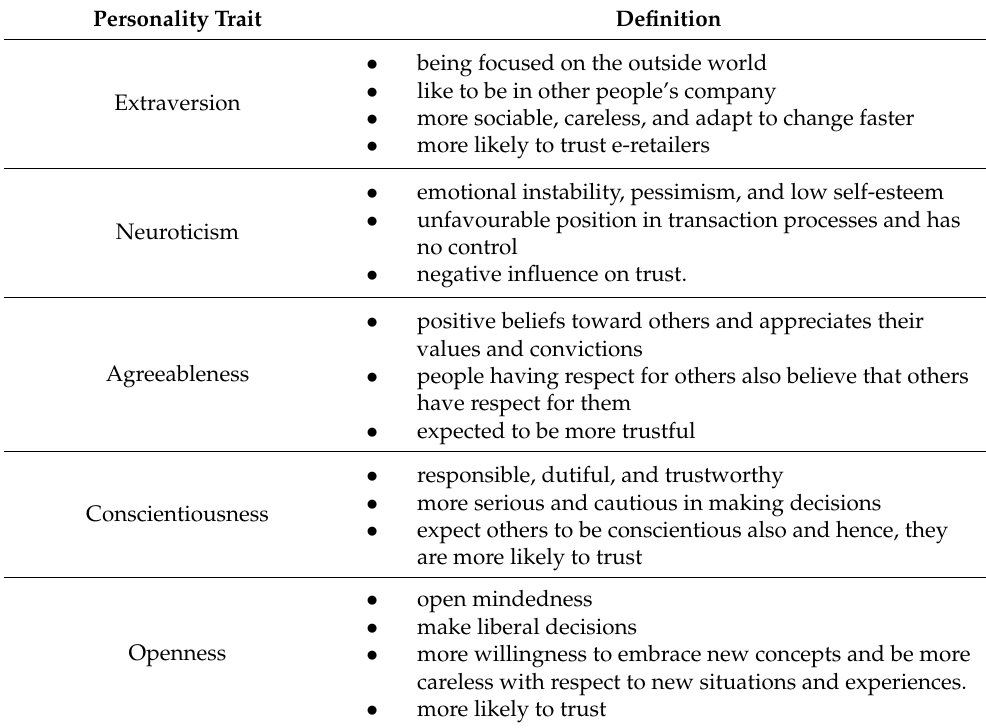
Table 1. Big Five Personality Traits and